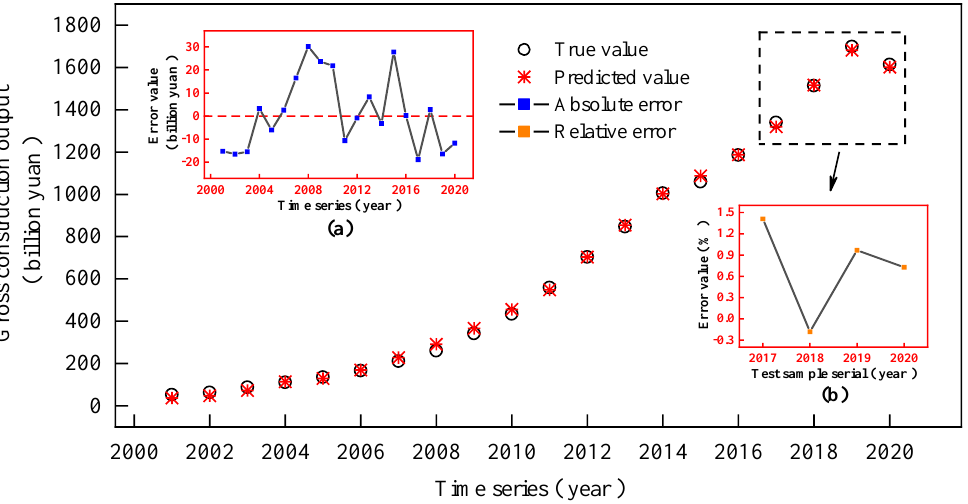
Figure 4. Fitting results of GSM-SVM forecast model for the construction industry output in Hubei. ( a ) total samples’ absolute error diagram, ( b ) testing samples’ relative error diagram.